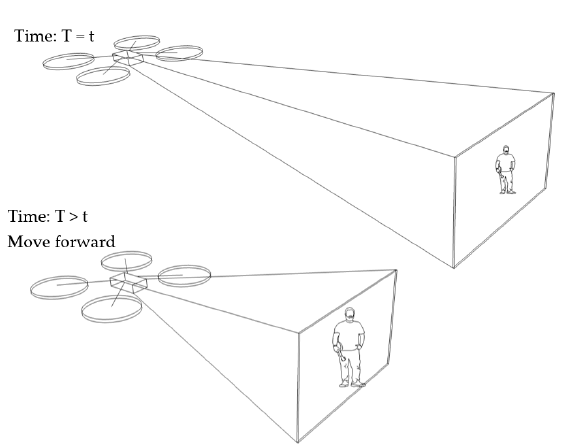
Figure 12. Human motion tracking when the drone moves